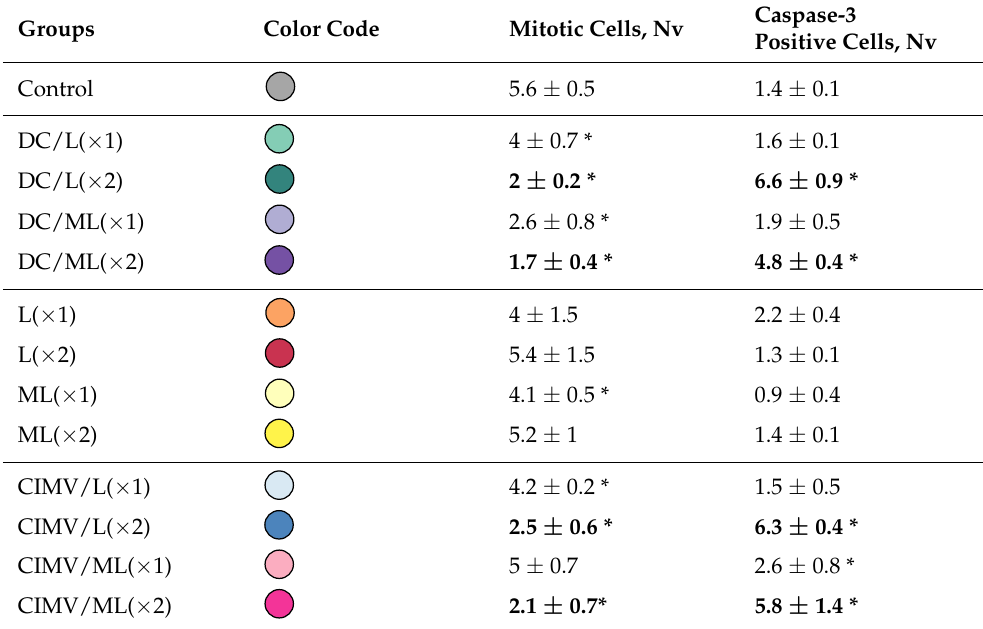
Pharmaceutics 2022 , 14 , 2542 16 of 30 Figure 4. Vaccines inhibit mitotic activity and induce apoptosis in RLS 40 lymphosarcoma tissue. Representative histological images of the tumor sections. Hematoxylin and eosin staining (upper indicate necrotic changes. Blue arrows indicate caspase-3-positive cells. Black boxes indicate typical panel) and immunohistochemical staining with anti-caspase-3 primary antibodies (bottom panel). Figure 4. Vaccines inhibit mitotic activity and induce apoptosis in RLS 40 lymphosarcoma tissue. Table 3. Morphometry of RLS 40 lymphosarcoma tissue of mice without treatment (control) and after examples of mitosis, necrosis, and granulocyte. Original magnification ×400. Black arrows indicate mitosis events. Red arrows indicate inflammatory infiltration. Green arrows Representative histological images of the tumor sections. Hematoxylin and eosin staining (upper vaccine Figure 4. Vaccines inhibit mitotic activity and induce apoptosis in RLS 40 lymphosarcoma tissue. indicate necrotic changes. Blue arrows indicate caspase-3-positive cells. Black boxes indicate typical panel) and immunohistochemical staining with anti-caspase-3 primary antibodies (bottom panel). Representative histological images of the tumor sections. Hematoxylin and eosin staining (upper Table 3. Morphometry of RLS 40 lymphosarcoma tissue of mice without treatment (control) and after examples of mitosis, necrosis, and granulocyte. Original magnification ×400. Black arrows indicate mitosis events. Red arrows indicate inflammatory infiltration. Green arrows panel) and immunohistochemical staining with anti-caspase-3 primary antibodies (bottom panel). vaccine administration. Figure 4. Vaccines inhibit mitotic activity and induce apoptosis in RLS 40 lymphosarcoma tissue. indicate necrotic changes. Blue arrows indicate caspase-3-positive cells. Black boxes indicate typical Black arrows indicate mitosis events. Red arrows indicate inflammatory infiltration. Green arrows Representative histological images of the tumor sections. Hematoxylin and eosin staining (upper Table 3. Morphometry of RLS 40 lymphosarcoma tissue of mice without treatment (control) and after examples of mitosis, necrosis, and granulocyte. Original magnification ×400. indicate necrotic changes. Blue arrows indicate caspase-3-positive cells. Black boxes indicate typical panel) and immunohistochemical staining with anti-caspase-3 primary antibodies (bottom panel). vaccine administration. Figure 4. Vaccines inhibit mitotic activity and induce apoptosis in RLS 40 lymphosarcoma tissue. examples of mitosis, necrosis, and granulocyte. Original magnification ×400. Black arrows indicate mitosis events. Red arrows indicate inflammatory infiltration. Green arrows Representative histological images of the tumor sections. Hematoxylin and eosin staining (upper Table 3. Morphometry of RLS 40 lymphosarcoma tissue of mice without treatment (control) and after indicate necrotic changes. Blue arrows indicate caspase-3-positive cells. Black boxes indicate typical panel) and immunohistochemical staining with anti-caspase-3 primary antibodies (bottom panel). vaccine administration. Figure 4. Vaccines inhibit mitotic activity and induce apoptosis in RLS 40 lymphosarcoma tissue. Table 3. Morphometry of RLS 40 lymphosarcoma tissue of mice without treatment (control) and after examples of mitosis, necrosis, and granulocyte. Original magnification ×400. Black arrows indicate mitosis events. Red arrows indicate inflammatory infiltration. Green arrows Representative histological images of the tumor sections. Hematoxylin and eosin staining (upper vaccine administration. Figure 4. Vaccines inhibit mitotic activity and induce apoptosis in RLS 40 lymphosarcoma tissue. indicate necrotic changes. Blue arrows indicate caspase-3-positive cells. Black boxes indicate typical panel) and immunohistochemical staining with anti-caspase-3 primary antibodies (bottom panel). Representative histological images of the tumor sections. Hematoxylin and eosin staining (upper Table 3. Morphometry of RLS 40 lymphosarcoma tissue of mice without treatment (control) and after examples of mitosis, necrosis, and granulocyte. Original magnification ×400. Black arrows indicate mitosis events. Red arrows indicate inflammatory infiltration. Green arrows panel) and immunohistochemical staining with anti-caspase-3 primary antibodies (bottom panel). vaccine administration. indicate necrotic changes. Blue arrows indicate caspase-3-positive cells. Black boxes indicate typical Black arrows indicate mitosis events. Red arrows indicate inflammatory infiltration. Green arrows Table 3. Morphometry of RLS 40 lymphosarcoma tissue of mice without treatment (control) and after examples of mitosis, necrosis, and granulocyte. Original magnification ×400. indicate necrotic changes. Blue arrows indicate caspase-3-positive cells. Black boxes indicate typical vaccine administration. examples of mitosis, necrosis, and granulocyte. Original magnification ×400. Table 3. Morphometry of RLS 40 lymphosarcoma tissue of mice without treatment (control) and after vaccine administration. Table 3. Morphometry of RLS 40 lymphosarcoma tissue of mice without treatment (control) and after Table 3. Morphometry of RLS 40 lymphosarcoma tissue of mice without treatment (control) and after vaccine administration. vaccine administration.